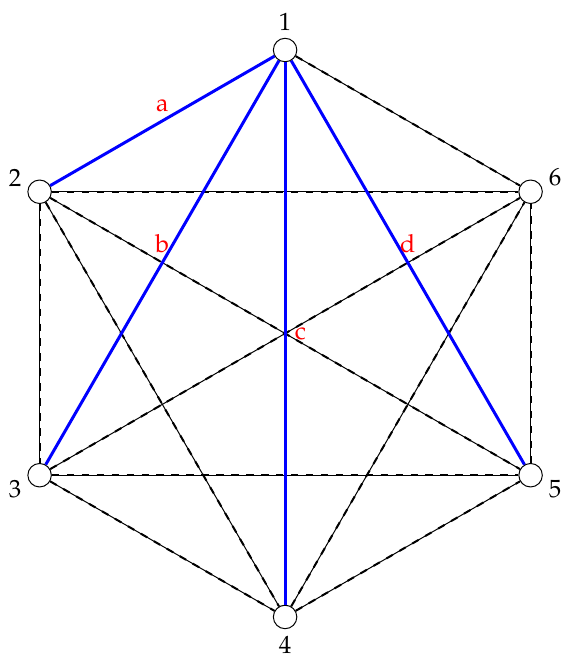
Figure 1. A graph where only the edges a , b , c and d exist. The dashed lines are used to indicate a lack of